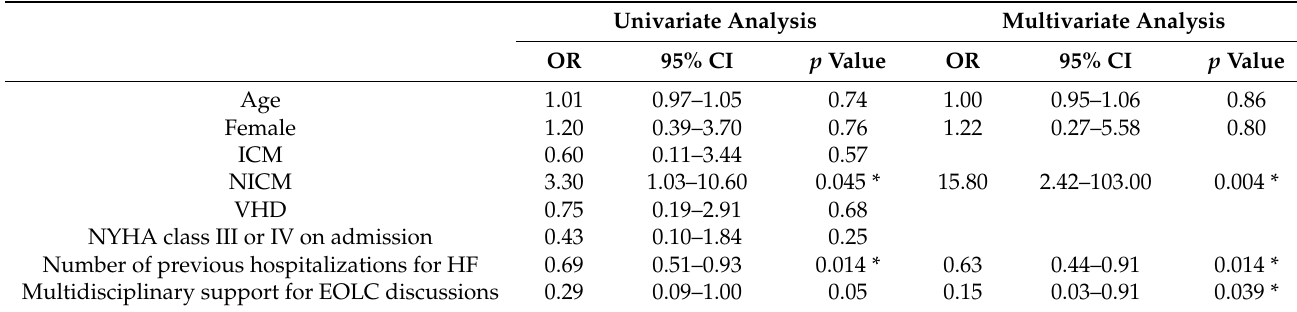
Table 4. Results of univariate and multivariate analysis associated with the administration of artificial nutrition three days prior to